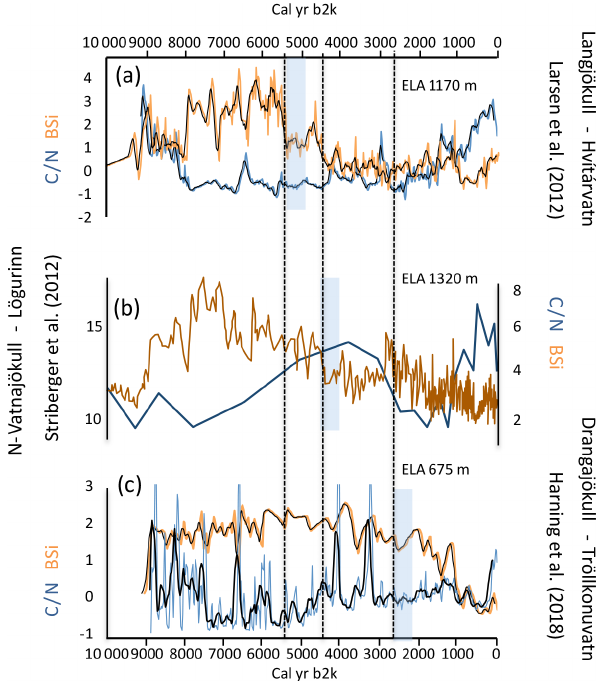
Figure 6. (a) BSi and C / N from HVT and Lögurinn. (b) BSi and C / N from Lögurinn; (c) BSi from TRK. Blue shaded bars indicates glacier inception at each lake